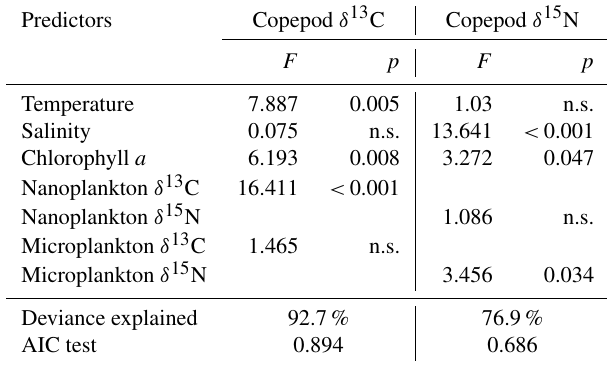
Table 3. Coefficients ( F) and significance levels ( p) of the effects of variable predictors on δ 13 C and δ 15 N copepods using a general- ized additive model test. P value < 0.05 indicates significance. The abbreviation “n.s.” stands for “no